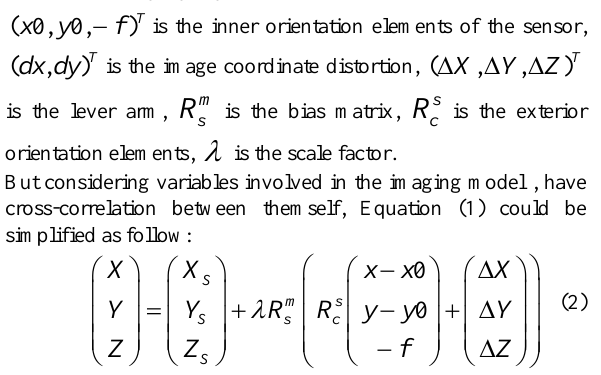
Figure 3. Processing Flow